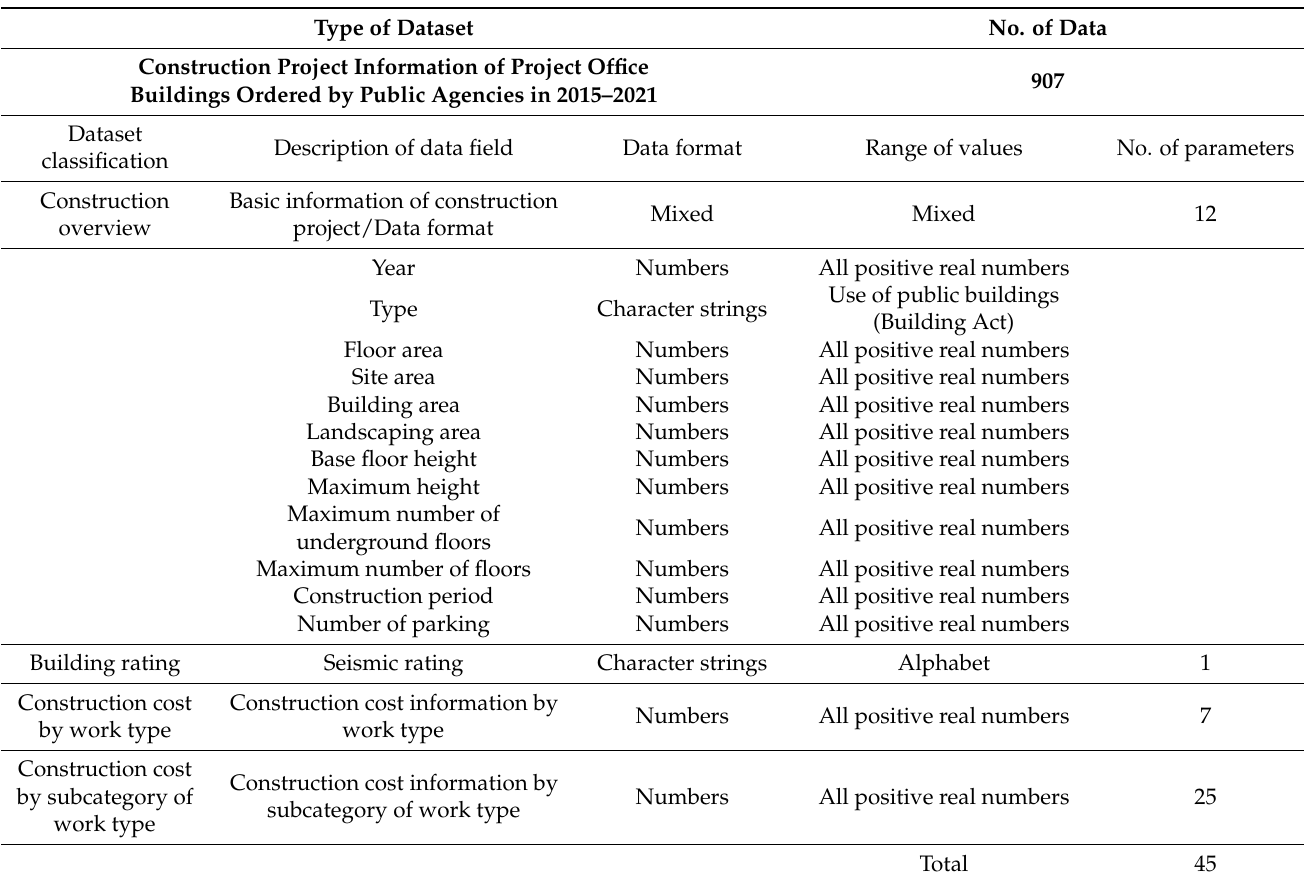
Table 1. Dataset